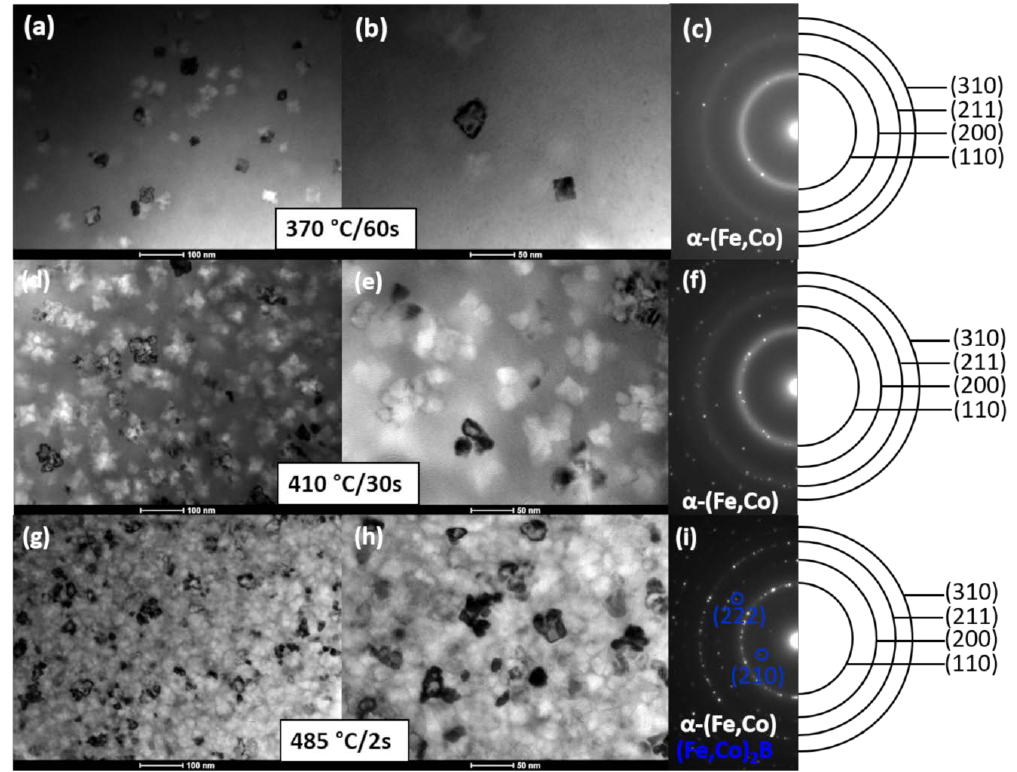
Figure 9. Set of BF images and corresponding SADPs for Fe 67 Co 20 B 13 ribbons heat-treated under various conditions: 370 °C/60 s ( a ), ( b ), ( c ), 410 °C/30 s ( d ), I, ( f ), and 485 °C/2 s ( g ), ( h ), ( i ).